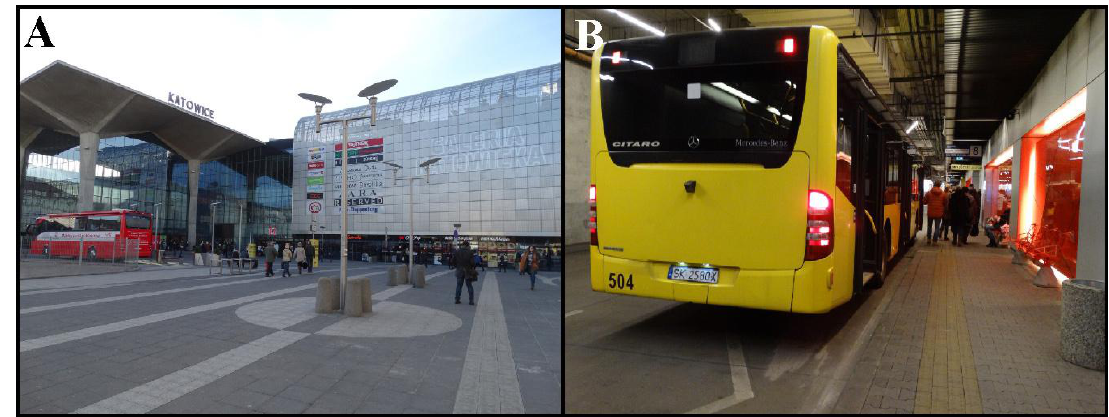
Fig. 6. The new railway station and Galeria Handlowa (shopping centre) in Katowice (A), underground bus station